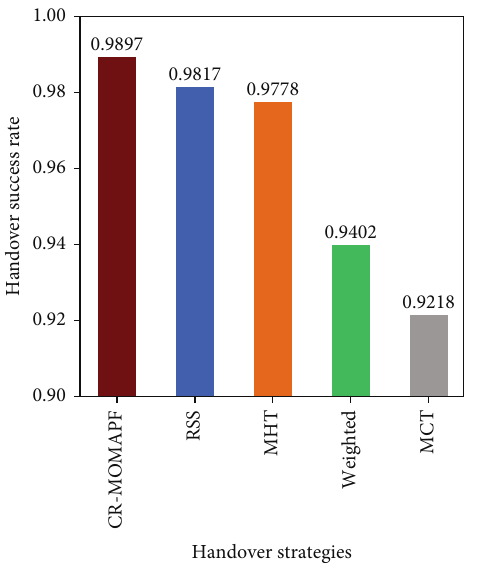
Figure 10: Comparison of handover success rate for fi ve di ff erent handover strategies.